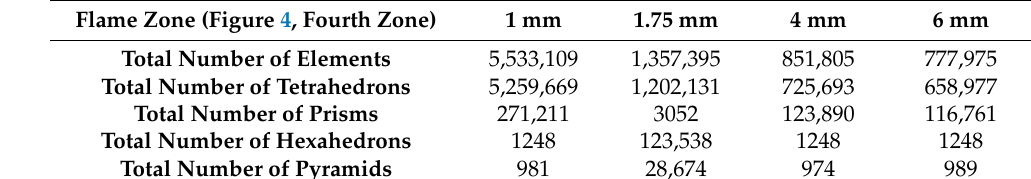
Table 1. Mesh statistics.